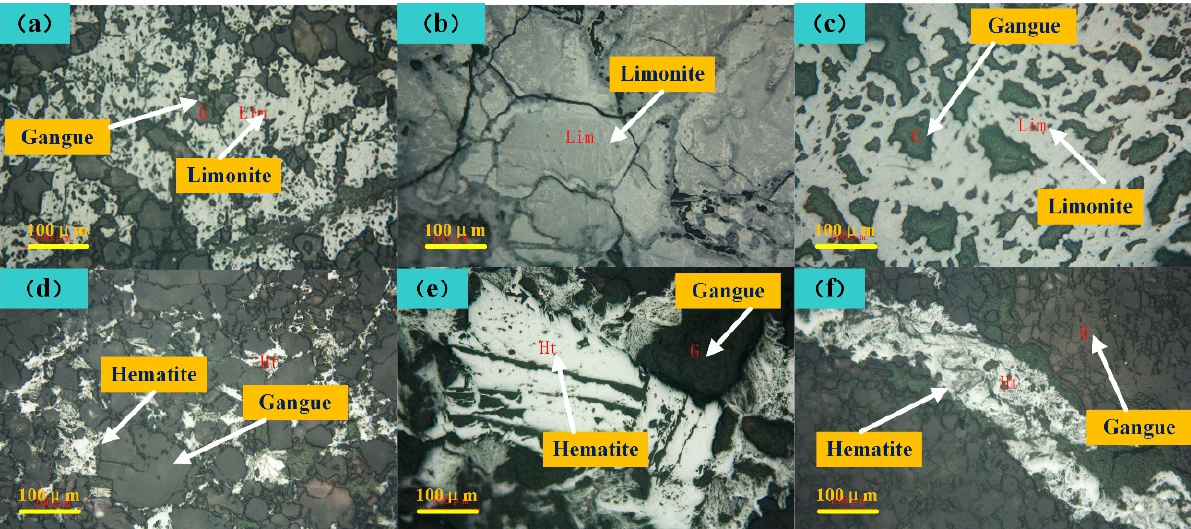
Figure 2. Distribution characteristics of the main minerals in the ore: ( a – c ) denote the limonite inlay structure; ( d – f ) denote the inlay structure of hematite.